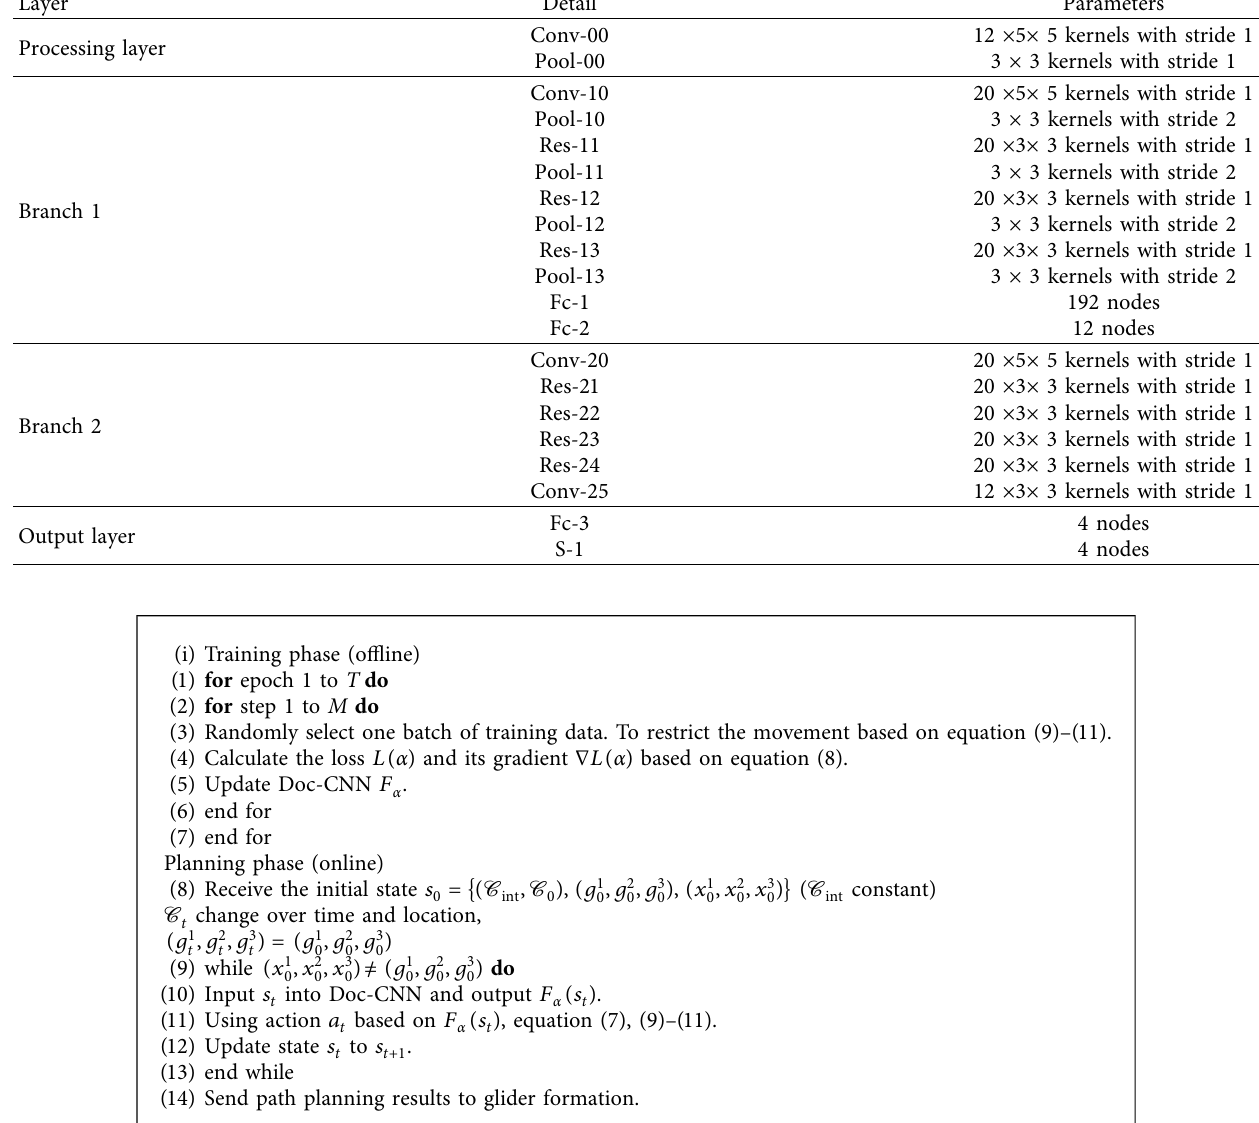
Table 1: Parameters of Doc-CNN (example of 128 × 128).